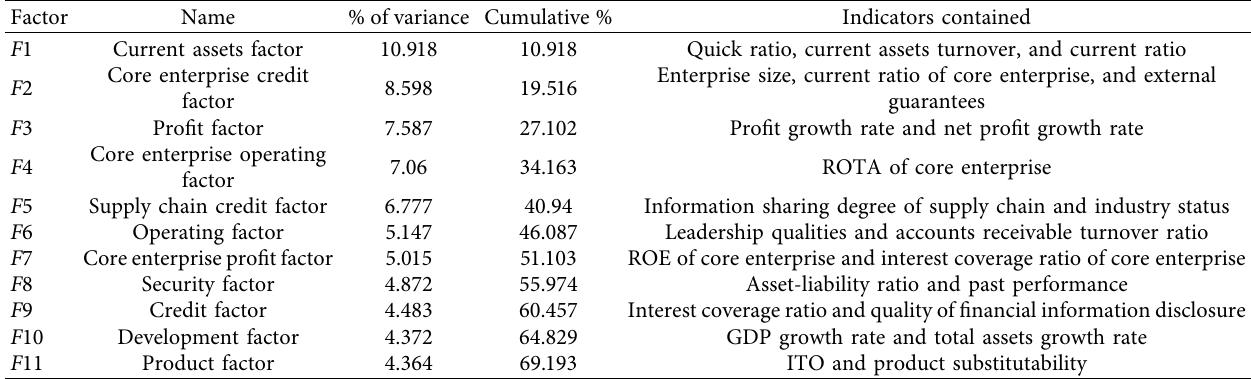
Table 9: Factor explanation table (control group).